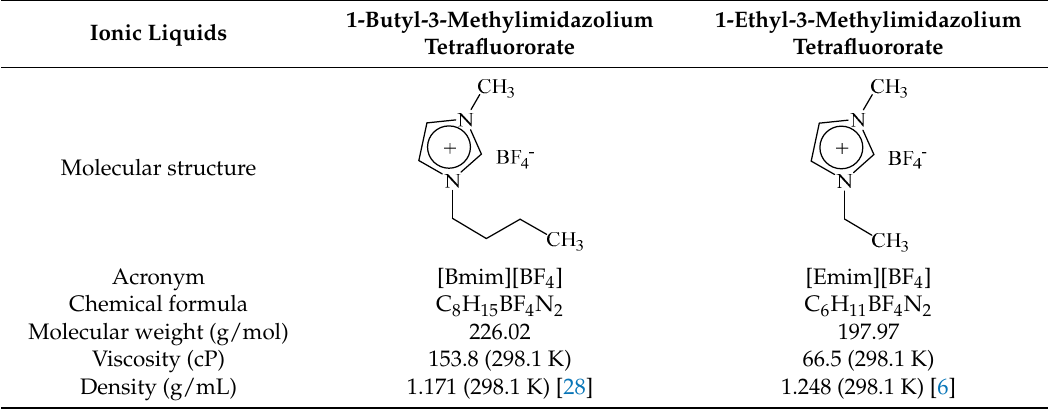
Table 2. Physical and chemical properties of ionic liquids used in this study.